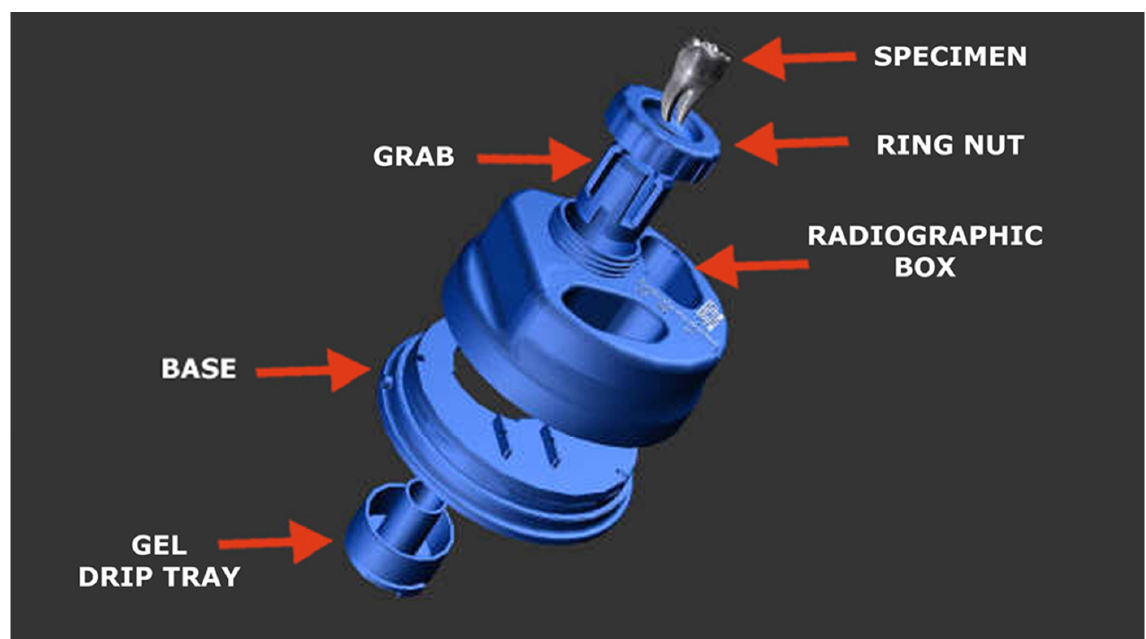
Figure 1. ProTrain and its exploded view.